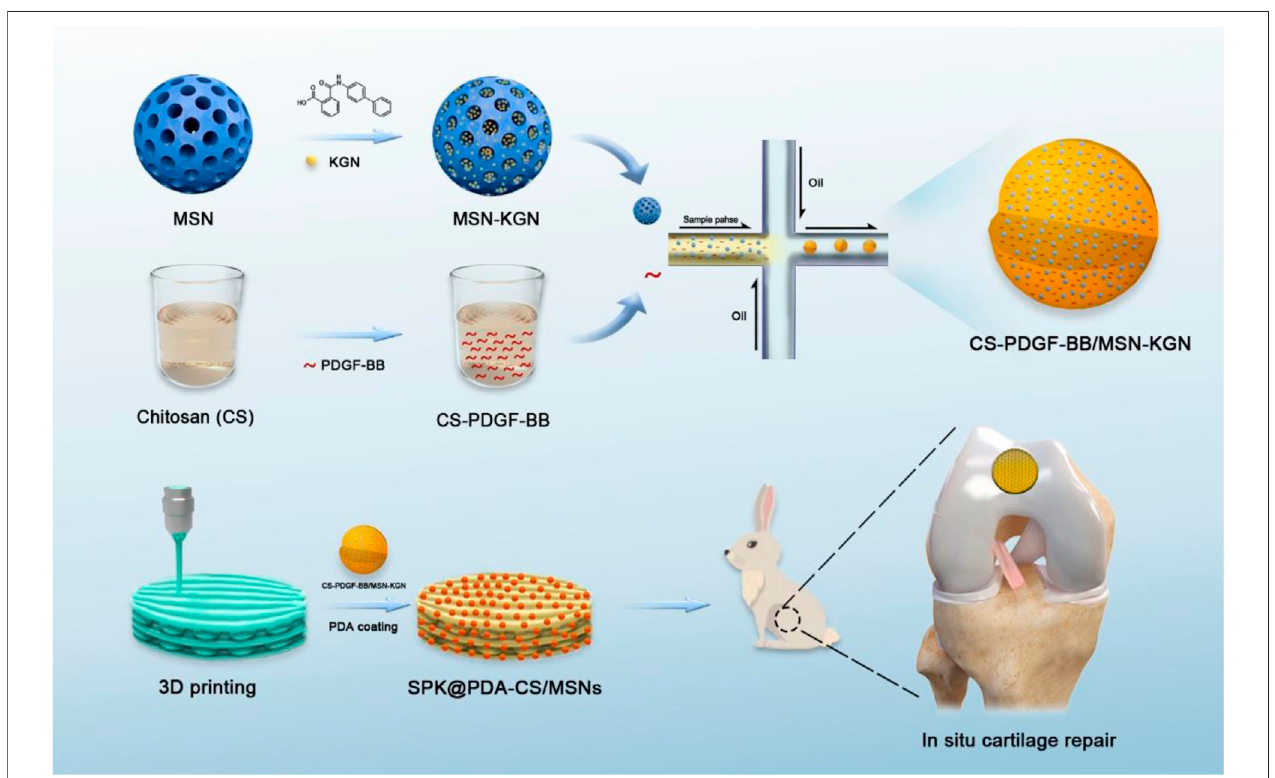
FIGURE1 | The schematic diagram of this